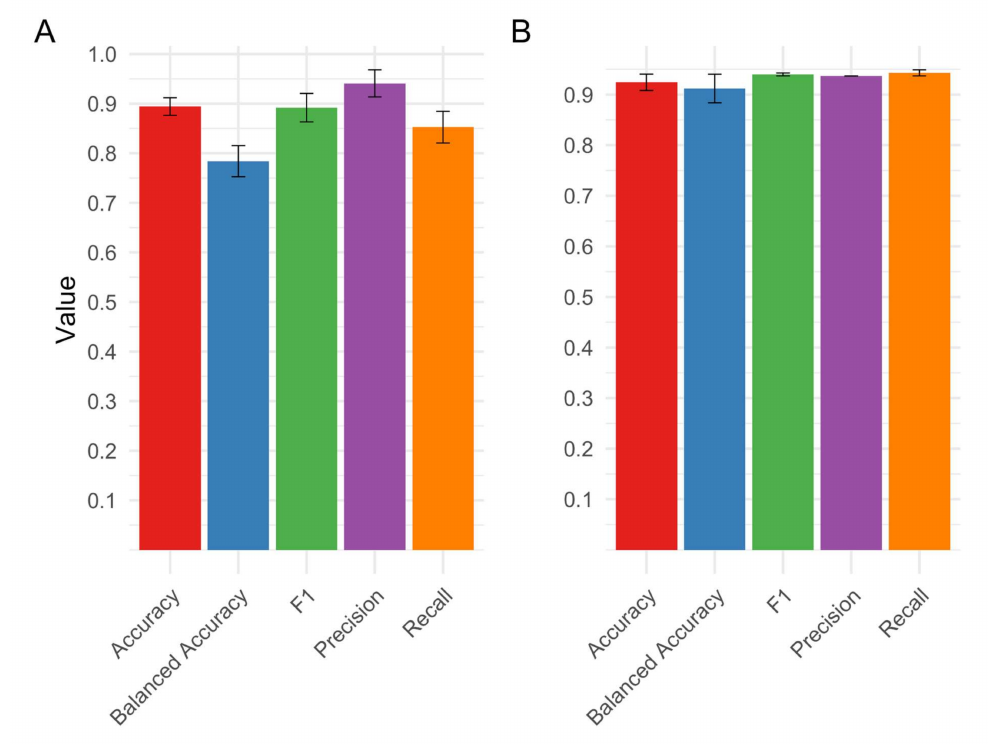
Figure 5. Overall performance (BASE + NDVI or Model 1) at Gunnison River and Engadin sites. ( A ) Mean metrics for Gunnison River basin, CO, USA; ( B ) mean metrics for Engadin, Switzerland. Bars show standard